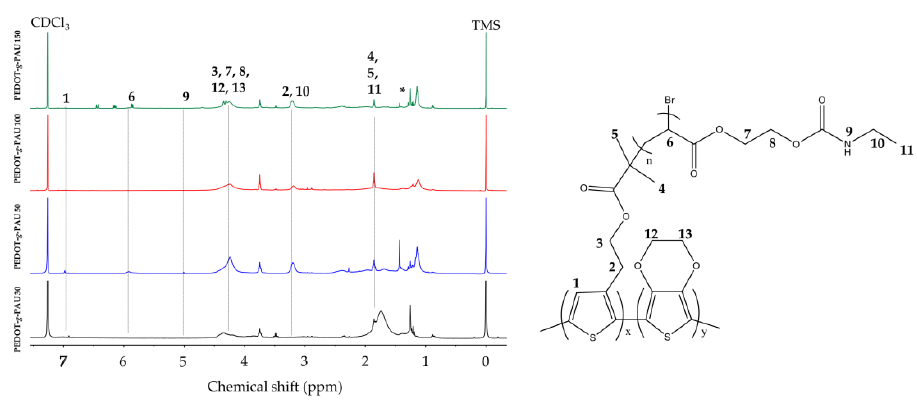
Figure 6. 1 H NMR spectrum of graft copolymer PEDOT- g -PAU.